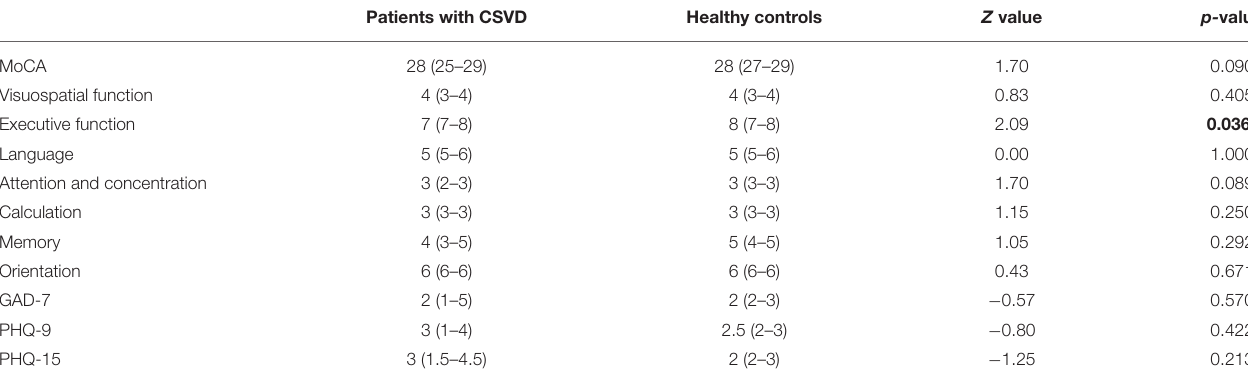
TABLE 2 | Neuropsychological and anxiety/depression/somatic symptom assessments of patients with CSVD and healthy controls. Patients with CSVD Healthy controls